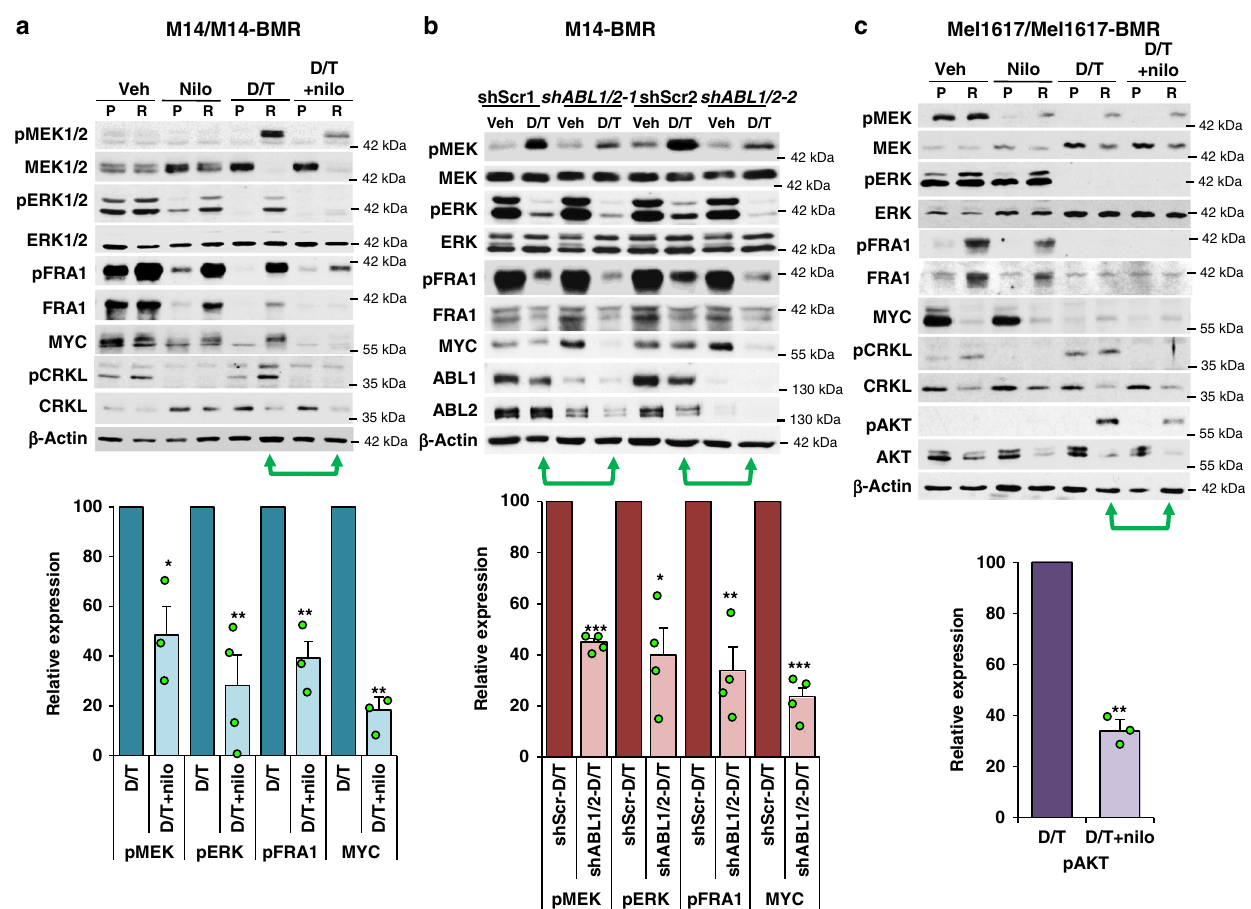
Fig. 5 Nilotinib prevents reactivation of ERK-dependent (or ERK-independent) signaling during BRAFi/MEKi resistance. a , c Parental or BRAFi/MEKi- resistant cells (-BMR) were treated with vehicle, nilotinib (nilo; 2.5 μ M), dabrafenib/trametinib (D/T; BRAFi/MEKi; 50/10 nM) or the combination for 24 h, and the resulting lysates probed with the indicated antibodies. Quantitation of key signaling molecules for n = 3 independent experiments (except pERK, n = 4) is shown below; green arrows indicate lanes quantitated. Mean± SEM * p < 0.05, ** p ≤ 0.01, *** p < 0.001 using two-sided, one-sample t -tests. Actual p values (left → right): a 0.045, 0.0099, 0.0033, and 0.004. c ** p = 0.0045. b M14-BMR cells expressing either vector (shScr) or IPTG-inducible shRNA targeting ABL1 and ABL 2 (sh ABL1/2 ; two independent clones are shown) were treated with IPTG (1 mM) for 10 days prior to plating to induce expression, treated with DMSO (vehicle) or D/T (100 nM/20 nM) for 24 h, and lysates blotted with the indicated antibodies. n = 4 biological replicates (using two vector and two shRNA clones). ** p ≤ 0.01, *** p < 0.001 using two-sided, one-sample t -tests. Actual p values (left → right): <0.0001, 0.011, 0.0056, and 0.000191. pCRKL (substrate of ABL1/2) is an indirect read-out of ABL1/2 activity and indicates the ef fi ciency of nilotinib-mediated inhibition. For all experiments, BRAFi/MEKi-resistant lines were maintained in dabrafenib (100 nM) and trametinib (20 nM), but were cultured for 2 days without BRAFi/ MEKi prior to plating for activates ERK1/2 and drives resistance. In BRAFi-resistant cells, RTKs can activate alternative MAP3Ks (CRAF, MAP3K8), which activate MEK1/2 thereby